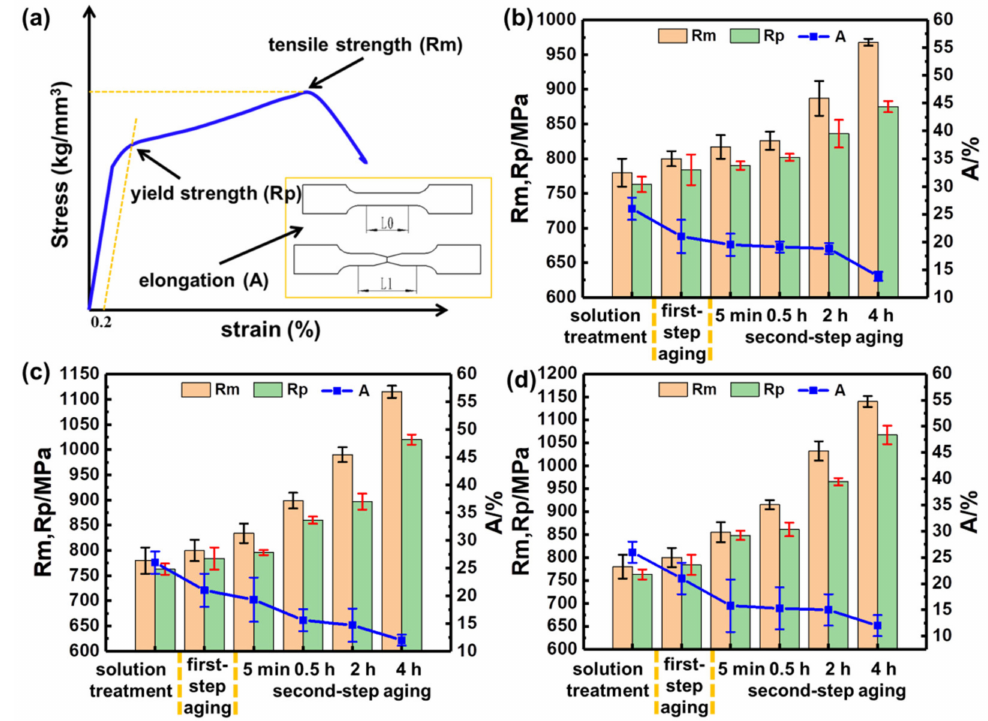
Figure 9. Mechanical properties after different HLDA: ( a ) diagram of the stretch symbol, ( b ) 450 ◦ C, ( c ) 500 ◦ C, ( d ) 550 ◦